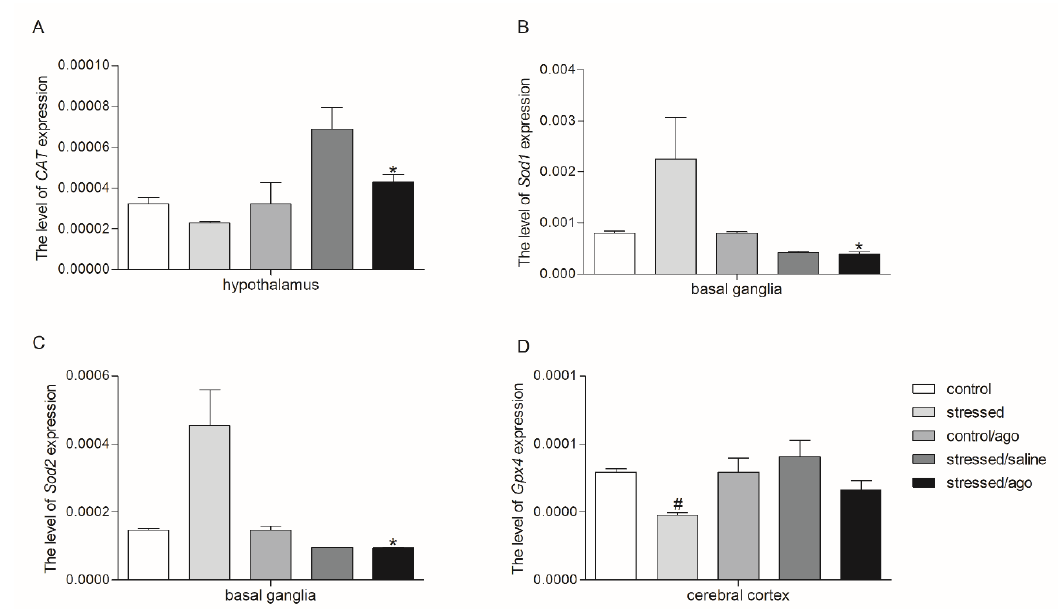
Figure 2. CAT ( A ) SOD1 ( B ), SOD2 ( C ), Gpx1 ( D ), Gpx4 ( E ), and NOS1 ( F ) mRNA expression in the hippocampus, amygdala, hypothalamus, midbrain, cerebral cortex and basal ganglia of animals exposed to CMS procedure for two weeks (Control, Stressed) and in animals exposed to CMS procedure for seven weeks and administered vehicle (1 mL / kg) or agomelatine (10 mg / kg) for five weeks (Control / Ago, Stressed / Saline, Stressed / Ago). Relative mRNA expression was estimated using a 2 − ∆ Ct (Ctgene–Ct18S) method. Data were presented as means ± SEM. N = 6. * p < 0.05 for di ff erences between stressed and stressed / ago groups, and # p < 0.05 for di ff erences between controls and stressed groups.